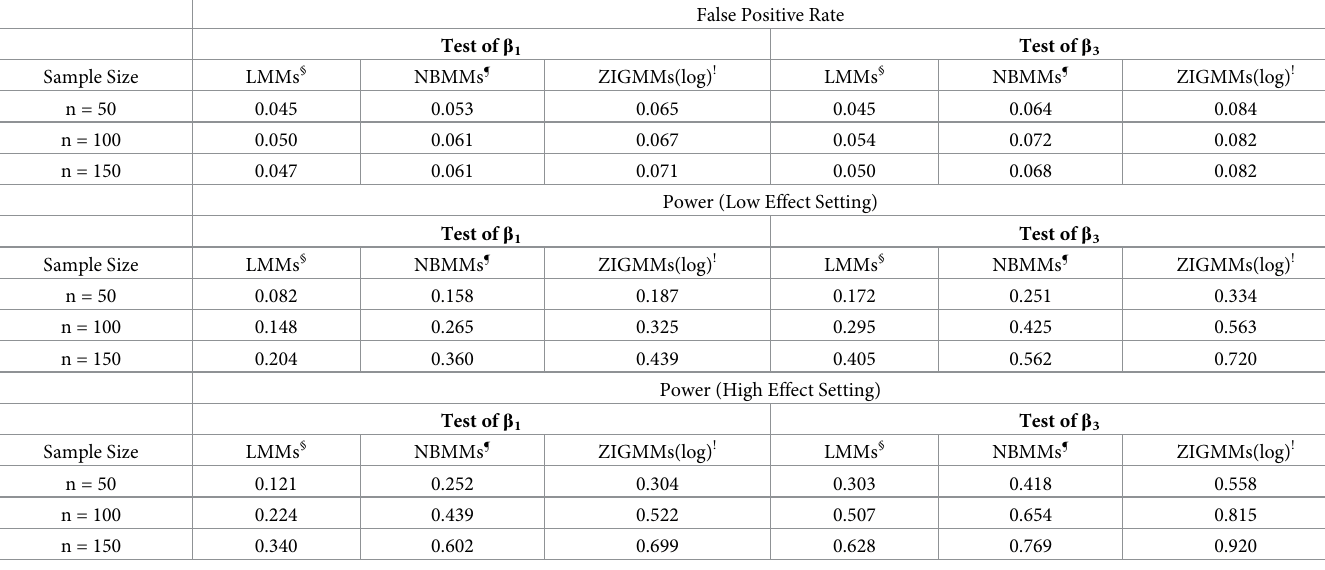
Table 3. False positive rate and power for testing H0: β 1 = 0 and H0: β 3 = 0 from setting E for significance level at 0.05 for various sample